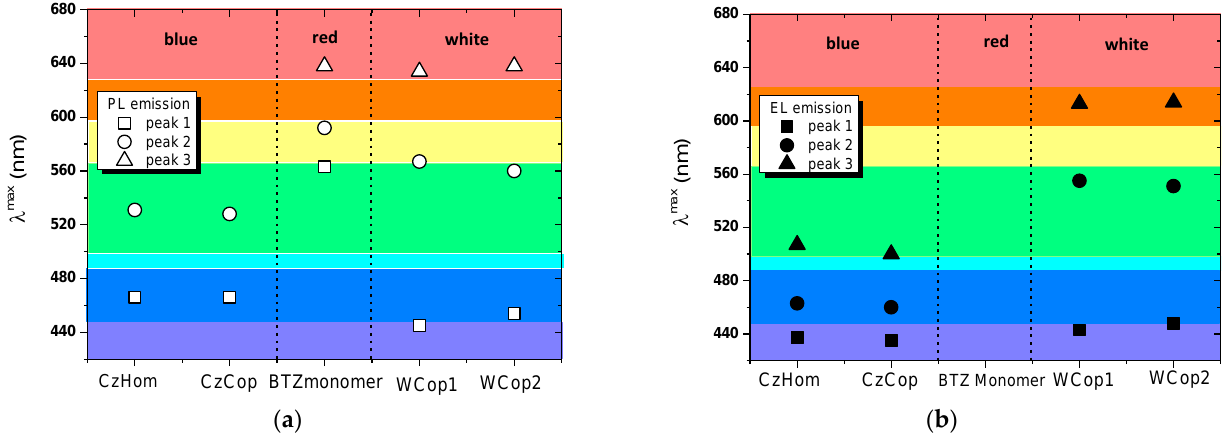
Figure 8. Schematical representation of the λ max of the peaks calculated though the deconvolution analysis of the ( a ) PL spectra of the CzHom, CzCop, BTZ, WCop1 and WCop2 films, and ( b ) EL spectra of the CzHom, CzCop, WCop1 and WCop2 devices.